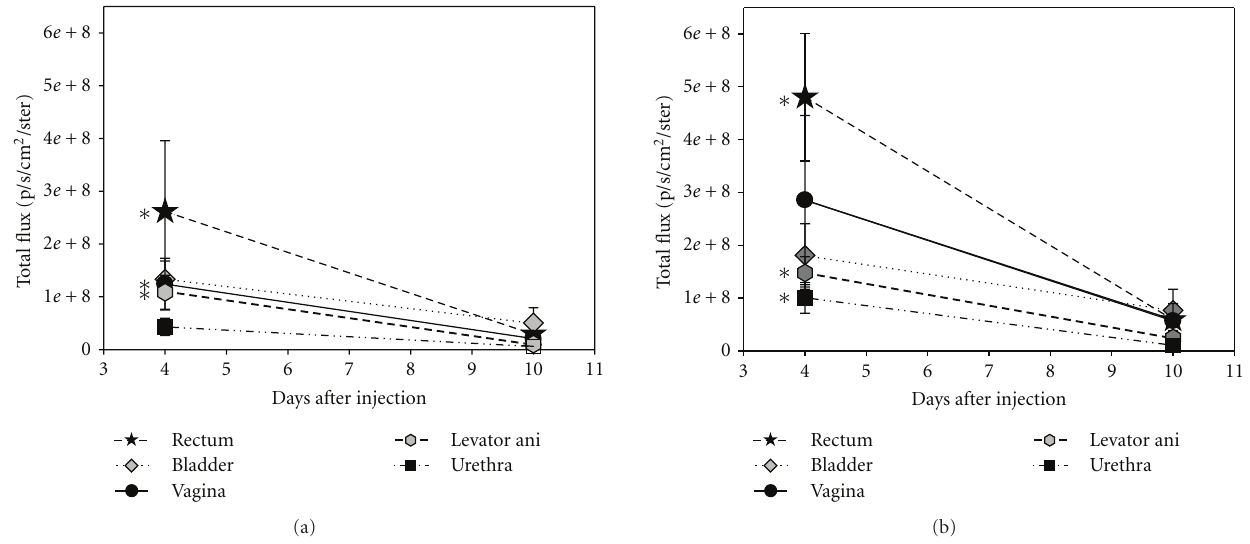
Figure 4: Total fluorescent flux 4 and 10 days after (a) sham vaginal distension and (b) vaginal distension (VD). Values are displayed as mean ± standard error of 5-6 animals/group. ∗ denotes a statistically significant di ff erence compared to the same organs 10 days after sham VD or VD ( P < 0 .